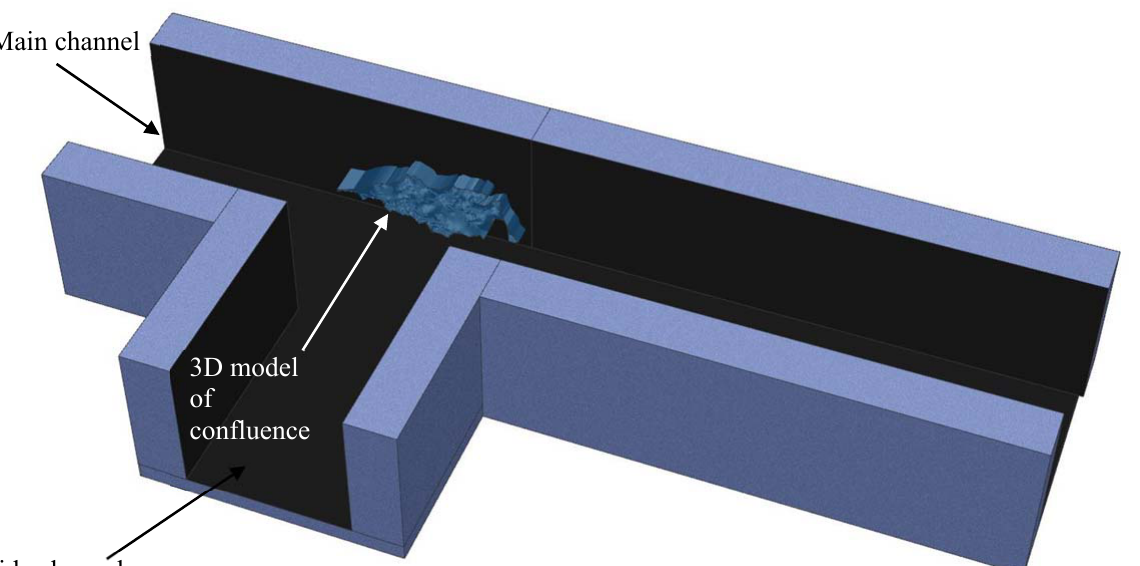
Figure 14. 3D model of confluence in testing facility